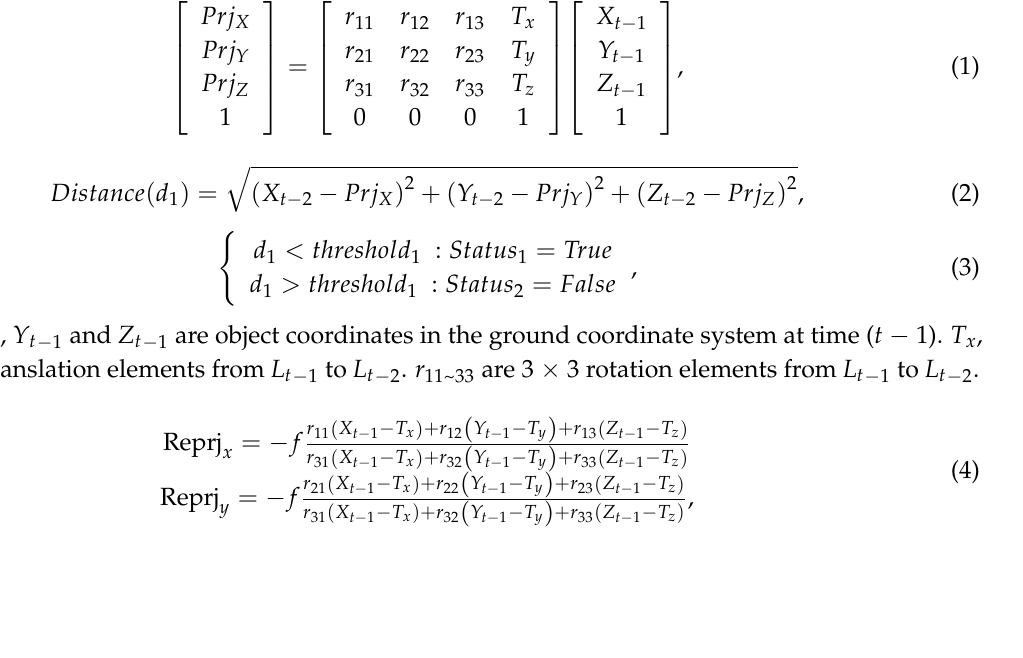
Figure 6. Multiple image filtering concept diagram. 2.3. Absolute Orientation for Pose Estimation